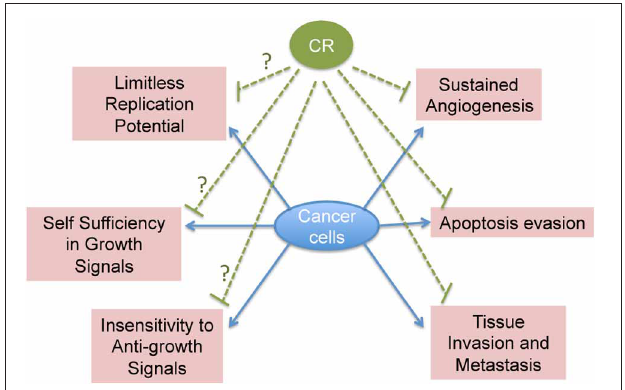
FIGURE 2 | Schematic representation of CR known and potential effects on cancer